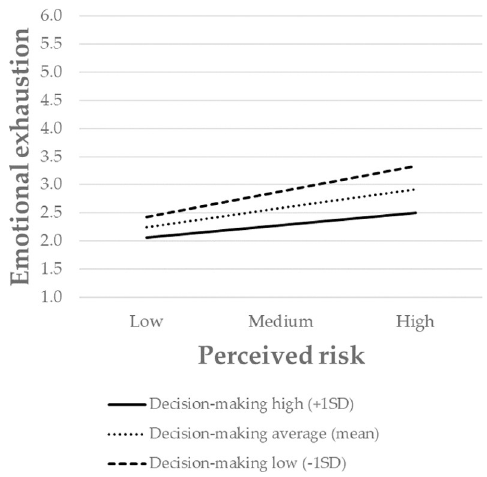
Fig 4. The moderating role of decision-making in the relationship between the perceived risk of being infected at work and emotional exhaustion. Perceived risk = perceived risk of being infected at work. SD = standard deviation.